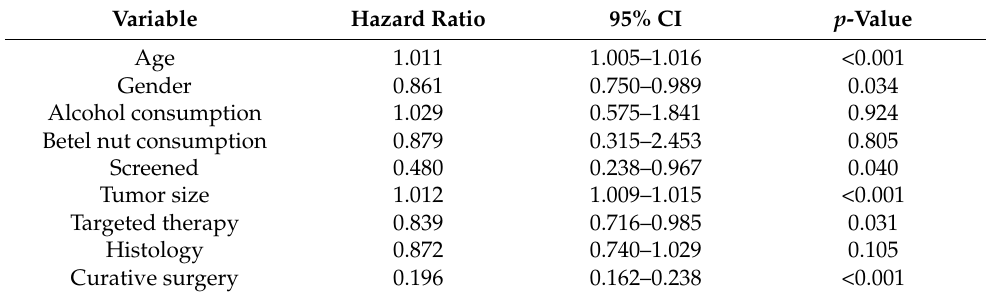
Table 3. Multivariate Cox regression model of prognostic factors for non-smokers with lung cancer.